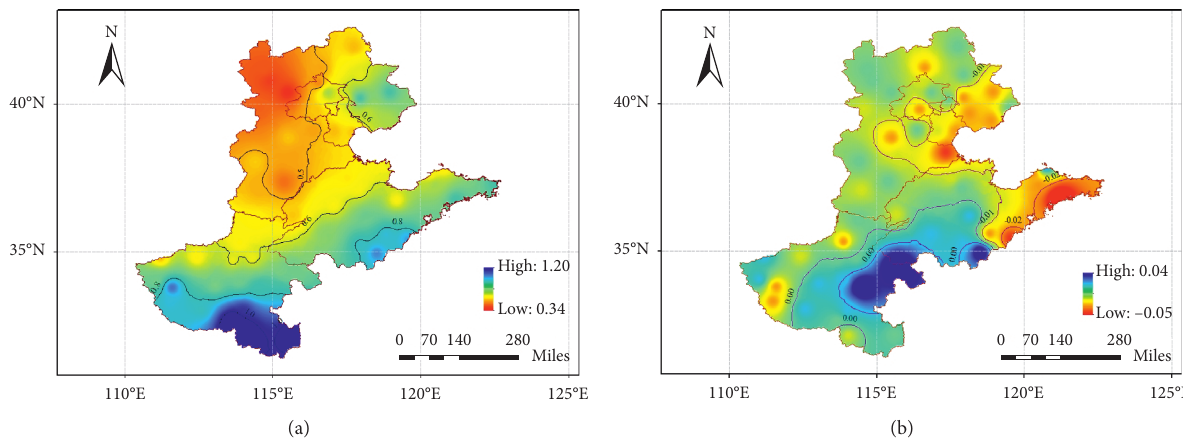
Figure 2: Spatial distribution of humidity index (a) and the tendency rate of humidity index (b) from 1961 to 2014.